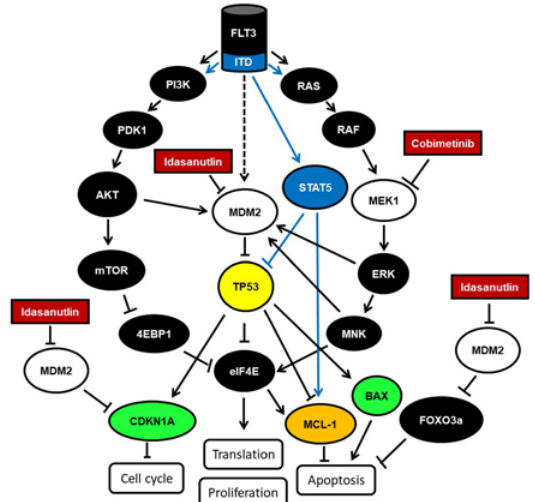
Figure 4. Schematic representation of the FLT3 signaling pathways and downstream effects. FLT3 is a growth factor receptor signaling via PI3K-PDK1-AKT and via RAS-RAF-MEK-ERK leading to cell growth and proliferation involving p53 inhibition. Idasanutlin and cobimetinib inhibit MDM2 and MEK1 leading to reactivation of the tumor suppressor p53 and to induction of CDKN1A and BAX gene expression as well as inhibition of MCL1 gene expression and in consequence to induction of cell cycle arrest and apoptosis. FLT3-ITD is a constitutively active FLT3 receptor signaling via PI3K-PDK1-AKT, via RAS-RAF-MEK-ERK and via STAT5.